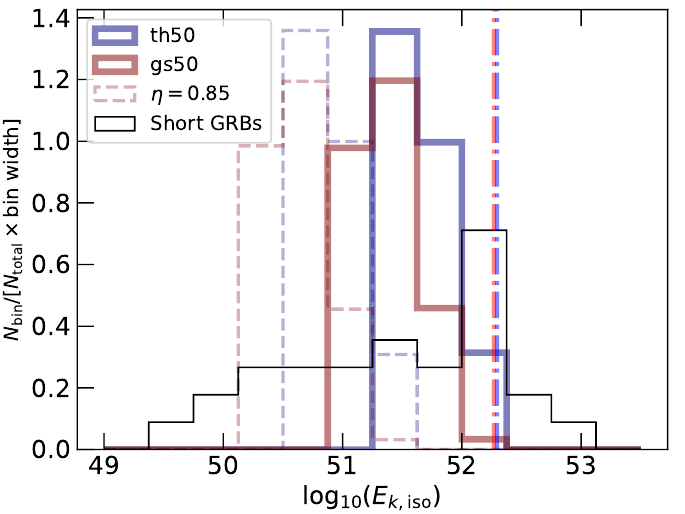
Figure 4. Probability density of the kinetic energy from our model jet structure profiles inferred from the peak afterglow flux, versus the observed short GRB kinetic energy distribution as listed in Fong et al. [6] for ε B = 0.01. For a fixed γ -ray efficiency ( η = 0.15), a single jet profile can account for ∼ one third of the observed logarithmic kinetic energy distribution range—the distribution with a fixed η = 0.85 is shown as a dashed line. The dash-dotted lines indicate the isotropic equivalent energy for each jet assuming the intrinsic jet energy, E j ∼ 10 49 erg, is contained within a cone defined by the jet structure profile core